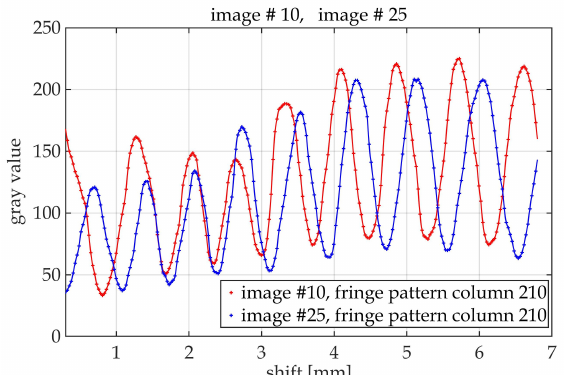
Figure 16. Line plot from image 10 and 25, mean distance maximum-maximum = 381(46) µ m, see also Table 1.